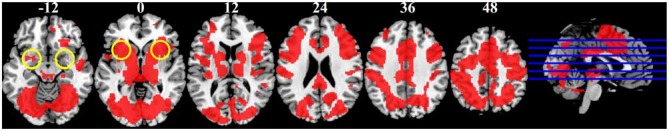
Regions significantly active across the three reputation conditions during reputation learning identified by conjunction analysis (p < 0.001, uncorrected for multiple comparisons; shown in red). Numbers above slices indicate z coordinates in MNI space. Yellow circles at z = −12 and z = 0 indicate approximate locations of the amygdala and the anterior insula, respectively.